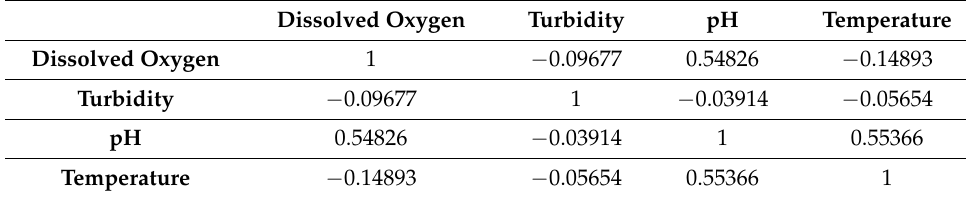
Table 1. Data correlation analysis